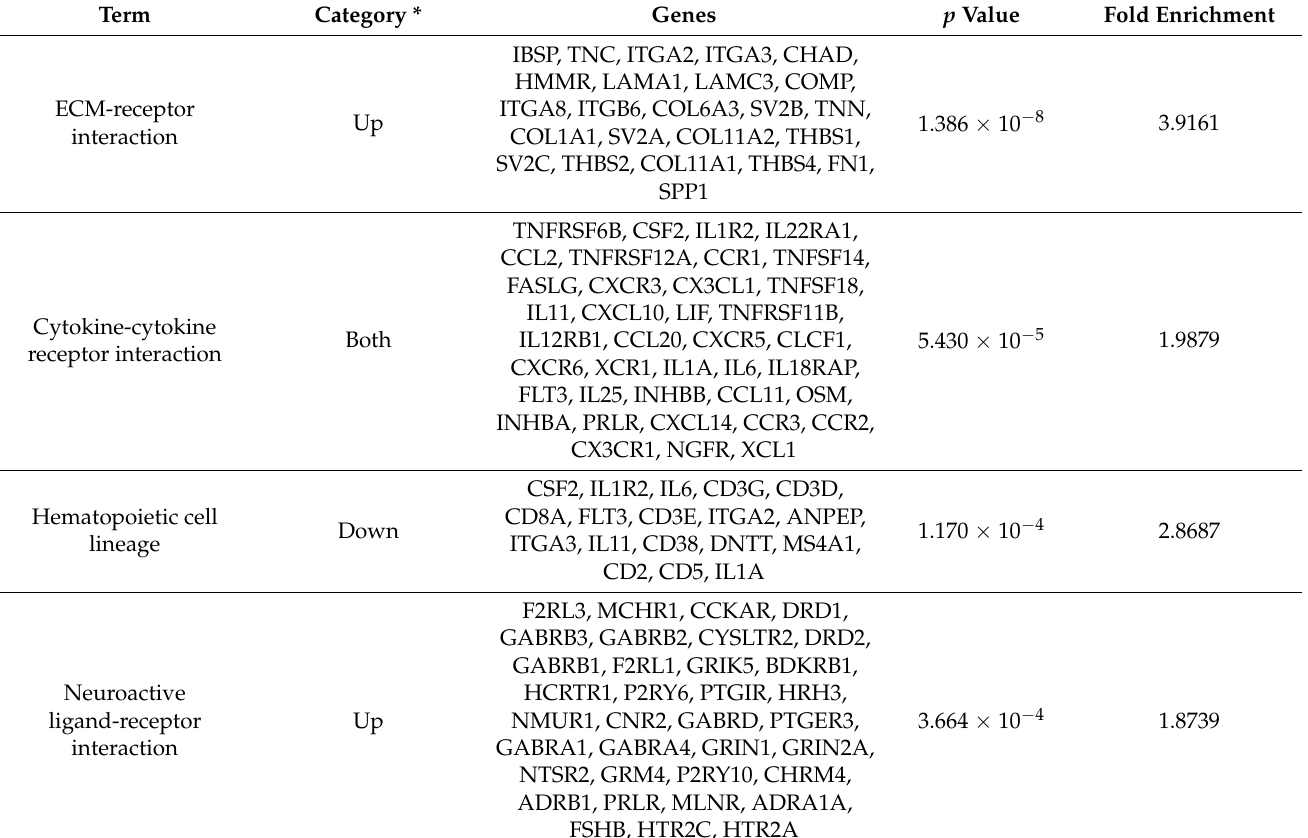
Figure 3. KEGG pathway enrichment analysis of XH-DEGs. Enrichment analysis of pathways associated with XH-DEGs was based on the KEGG databases using the DAVID database (https://david-d.ncifcrf.gov). Down-regulated and up-regulated pathways are shown on the left and right, respectively. The light color represents fold enrichment and dark color indicates − log10 p -value. Cutoff p -value < 0.05. Table 2. A summary of the KEGG pathway analysis for